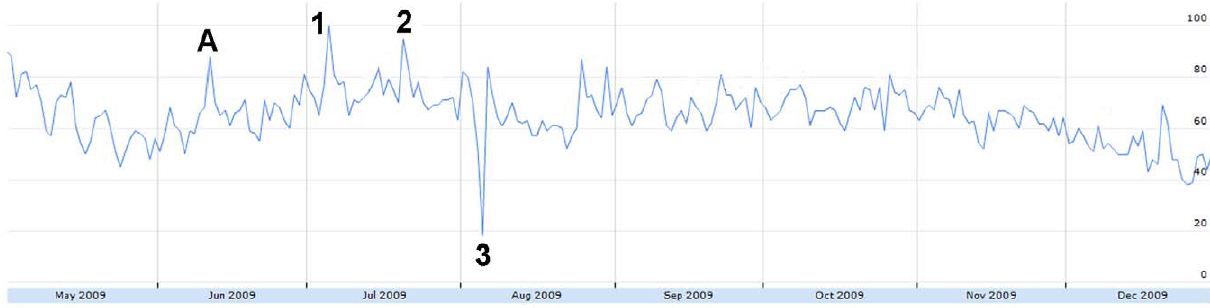
Figure 14. The relative proportion of tweets sharing questions from May 1 to December 31, 2009. Figure was scaled to the highest peak on July 5 where 18.99% of all tweets shared questions. The peak was assigned a score of 100. A=June 11: WHO pandemic level 6 announcement. 1=July 5: Harry Potter actor Rupert Grint has H1N1. 2=July 20: Viral dissemination of the ‘‘face mask (H1N1) versus condom (AIDS) comparison.’’ 3=August 5: Unexplained drop in questions.